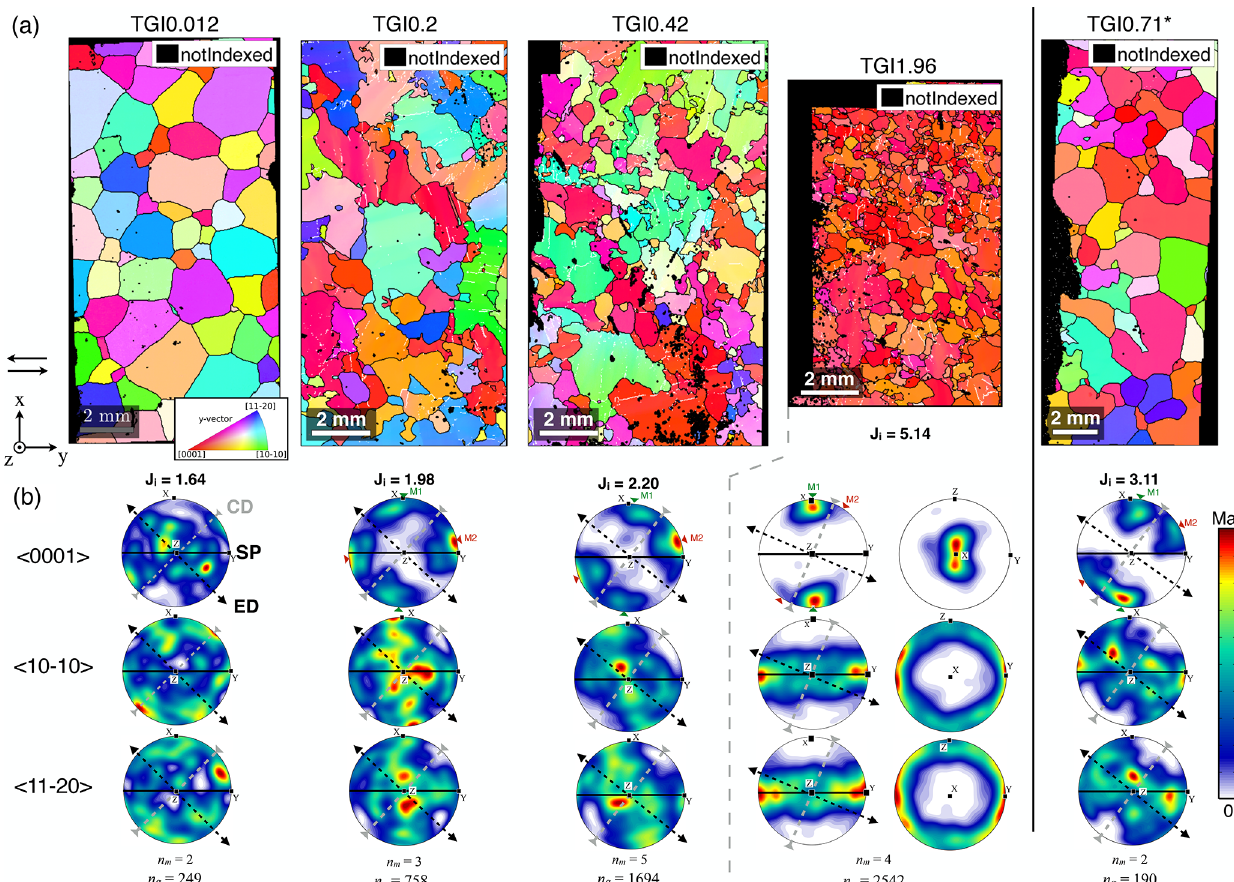
Figure 4. (a) Example of EBSD patterns obtained from tangential sections for each maximal shear strain, at − 7 ◦ C. Map colors correspond to the orientation of the crystallographic lattice toward to the y axis (torsion axis), as indicated in the inverse pole figure on the TGI0.012 EBSD map (top left). Red grains have < 0001 > ( c axis) parallel to the torsion axis, green grains have < 1010 > ( a axis) parallel to the torsion axis and blue grains have < 1120 > ( m axis). Boundaries with misorientation greater than 5 ◦ are represented by black lines and boundaries between 1 and 5 ◦ are depicted as white lines. (b) Lower hemisphere pole figures (equal area) representing the orientations of < 0001 > , < 1010 > and < 1120 > directions of the EBSD data were combined for each γ max . Additional pole figures projected normal to the x direction are represented for γ max = 1 . 96. Orientation density intensities are scaled to their maximum value for better readability. Associated c axis texture (CPO) J index is indicated above the pole figure. The shear plane (SP) is indicated as a black line, and the finite extension (ED) and compression (CD) directions are represented by black and grey dashed lines, respectively. The number of maps used to obtain the pole figures is indicated as n m and the total number of grains segmented as n g